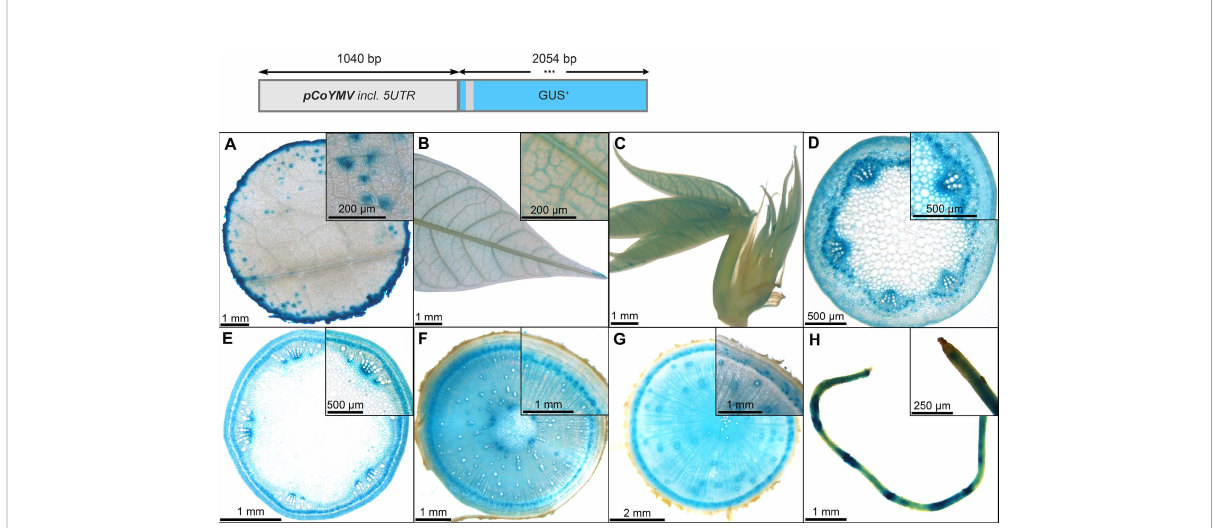
FIGURE 6 Representative GUS staining pattern of four pCoYMV promoter-reporter lines. (A) Source leaf (Inlay = Close-up), (B) Sink leaf (Inlay = Close-up), (C) Emerging leaves, (D) Petiole cross-section (Inlay = Close-up), (E) Upper stem cross-section (Inlay = Close-up), (F) Lower stem cross-section (Inlay = Close-up), (G) Storage root cross-section (Inlay = Close-up), (H) Fibrous roots (Inlay = Root